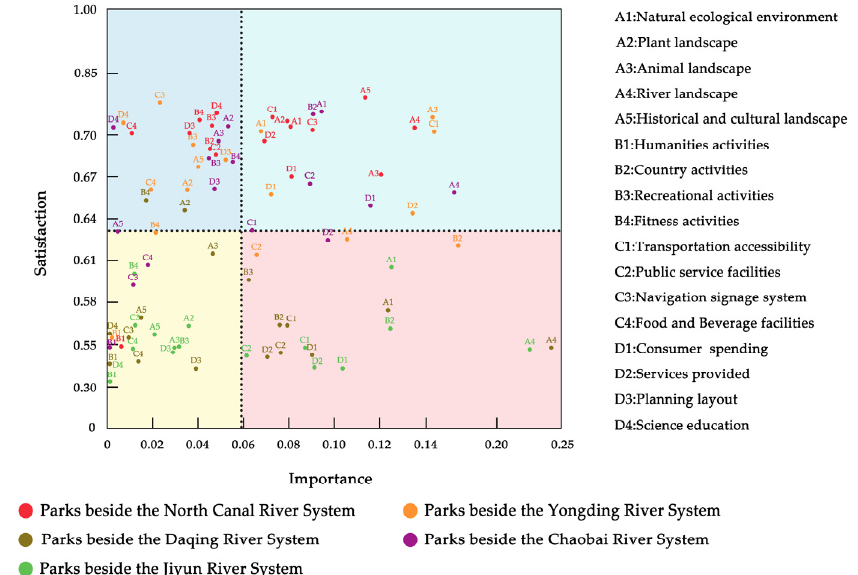
Figure 6. IPA model of riverside parks beside different river systems based on spatial landscape design.